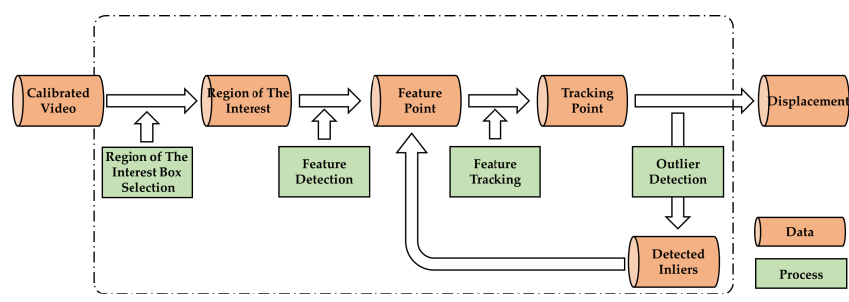
Figure 2. Overview of the vision-based displacement technique [14] .